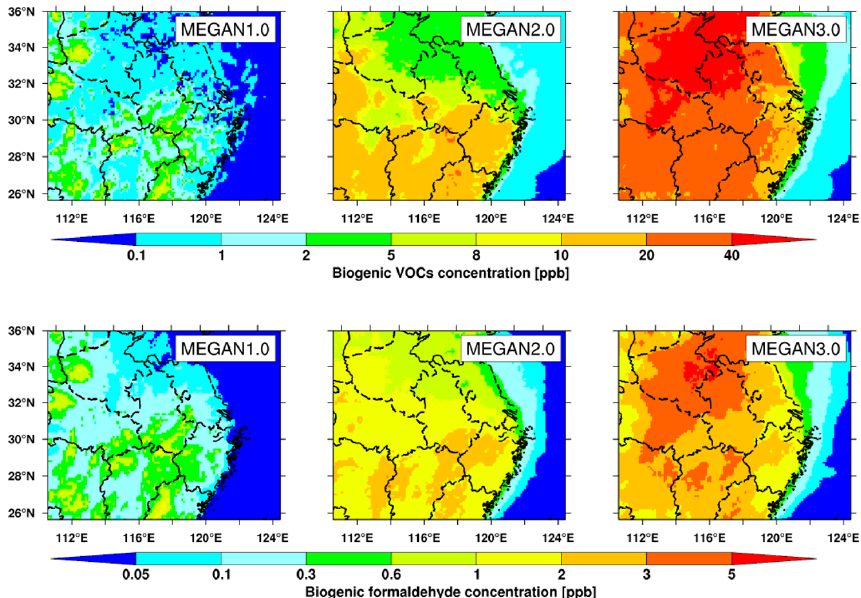
Figure 11. Spatial distribution of VOCs and formaldehyde concentration due to the biogenic emissions (minus anthropogenic emissions) near the surface in July using the VEG-2015 vegetation